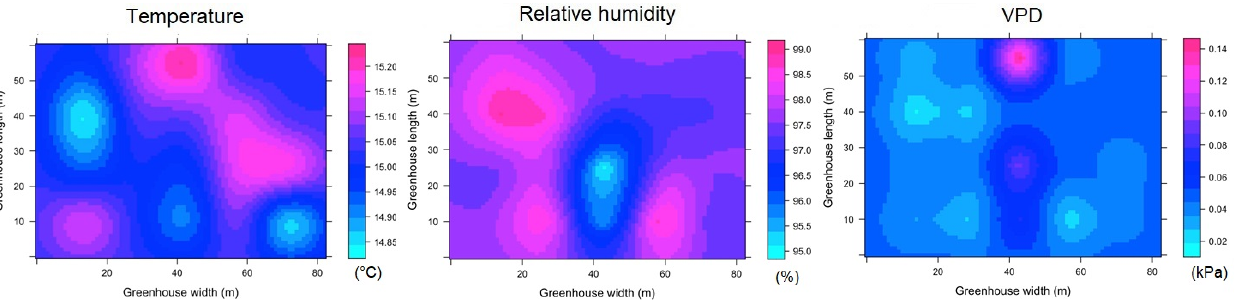
Figure A12. Spatial distribution predicted by kriging, for temperature, relative humidity and VPD in HGT1 and for ESRL 4.